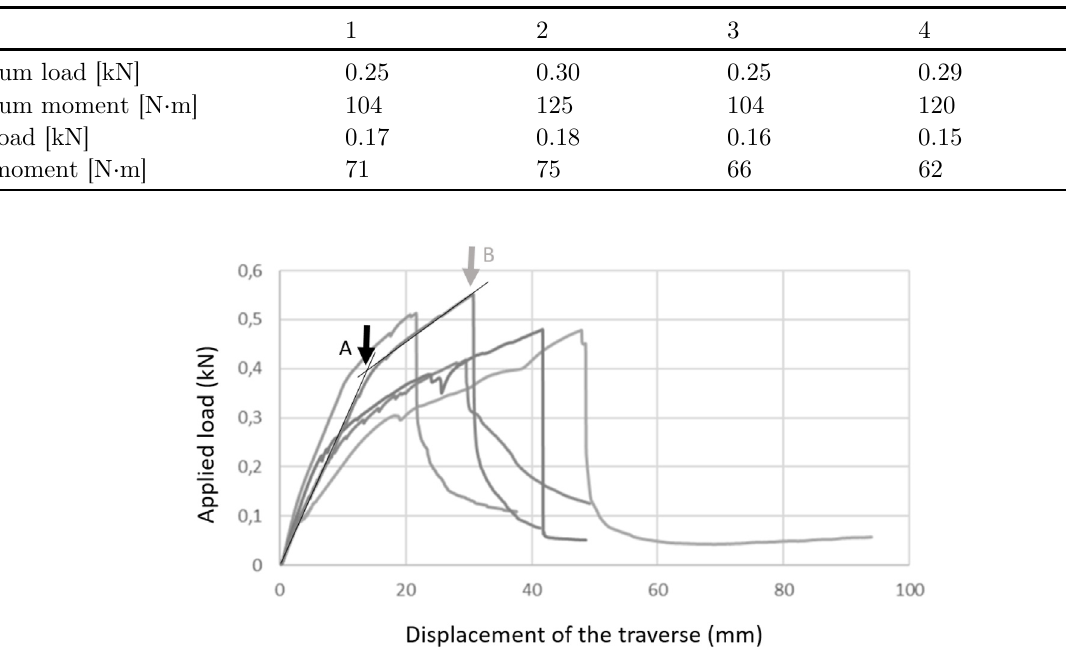
Fig. 8. One-screw assembly: evolution of the applied load as a function of the displacement. For each load-displacement curve, the intersection between the two tangential lines of the linear elastic behavior and of the fi rst plastic zone de fi nes the limit load (black arrow), while the discontinuity before complete failure de fi nes the maximum load (gray arrow). Table 4. One-screw assembly: summary table of limit and maximum load values.